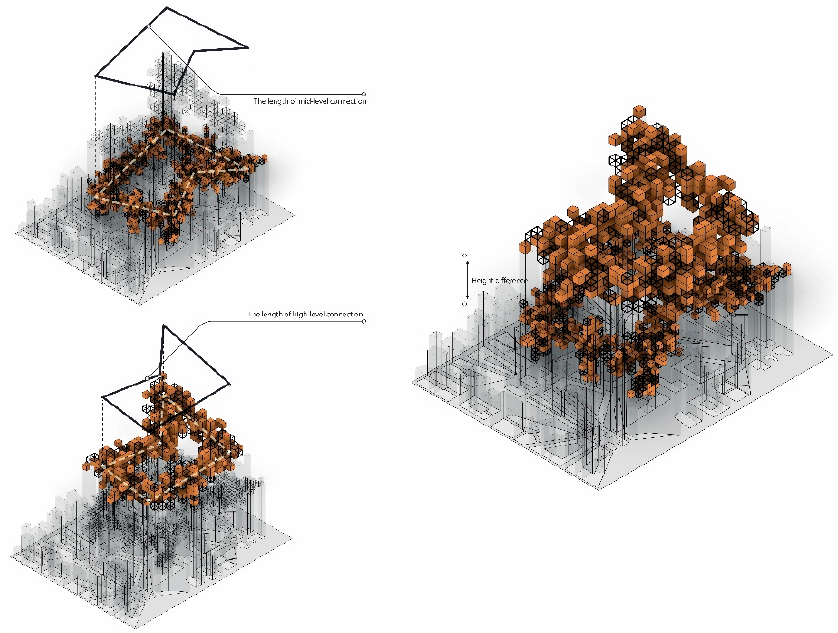
Figure 11. Fitness Function 2: Length and distribution of the spatial interventions throughout the superblock.